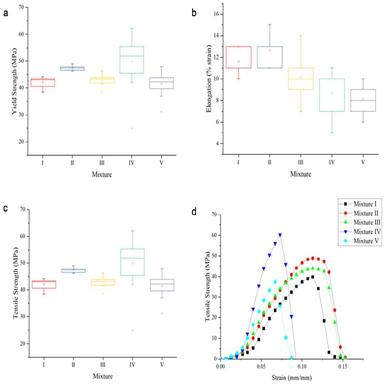
Box plot comparison of (a) tensile strength; (b) ductility; (c) Young's modulus; (d) a representative sample of each mixture after tensile testing.